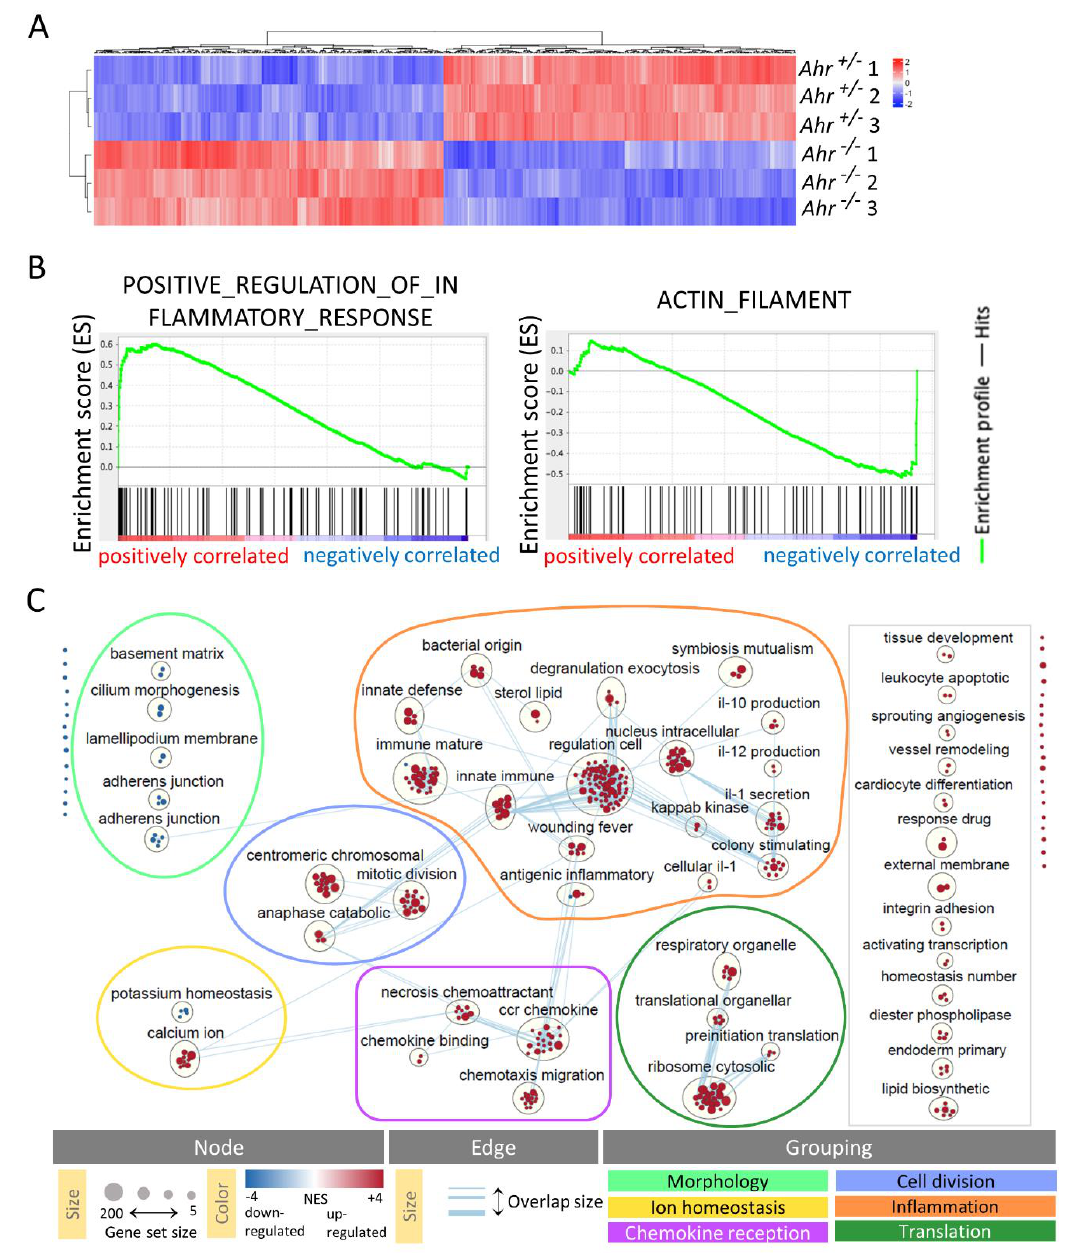
Figure 2. Comparative analysis of the transcriptome of Ahr -/- and Ahr +/- dendritic epidermal T cells (DETC). RNA of DETC, isolated by fluorescent activated cell sorting (FACS) from 2 – 3 mice two weeks of age, was pooled for one sample and analyzed on a microarray. Thereby data from 3 arrays for each Ahr +/- and Ahr -/- DETC were generated (n = 3 arrays) . ( A ) Heatmapped expression levels of genes differentially regulated with an FDR adj. p -value ( q -value) q < 0.5 ( B ) selected enrichment plots for one positive associated pathway (left panel; p -value < 0.001; q -value = 0.004) and one